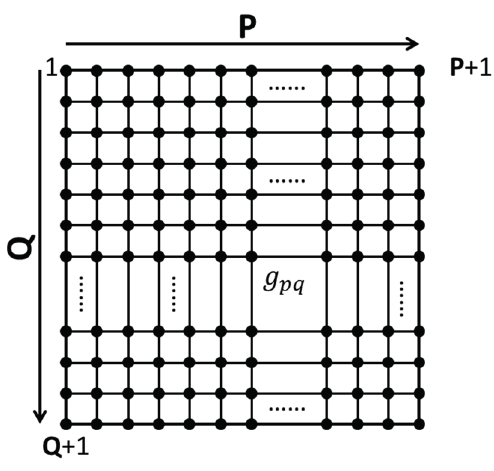
Figure 1. Grids of inspection